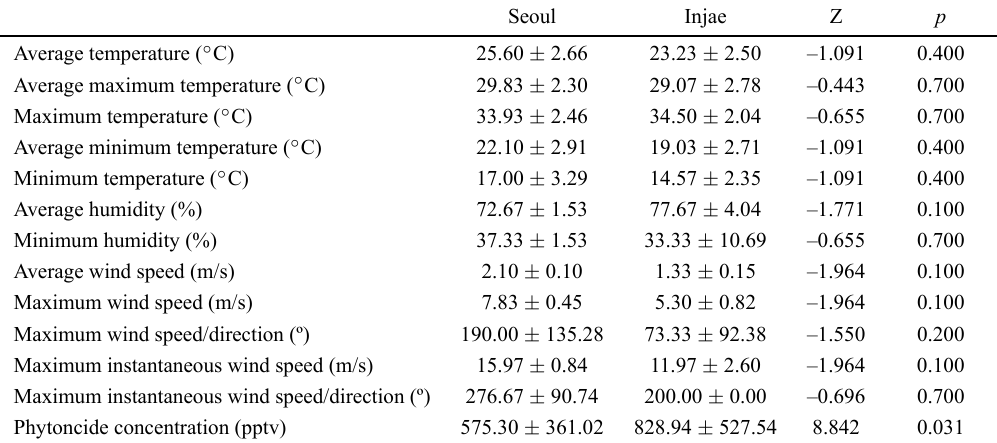
Table 2. The environmental characteristics and differences between Seoul and